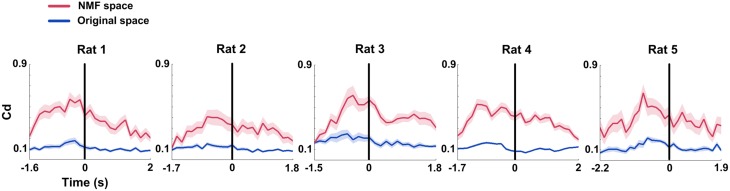
Causal density (Cd) of mPFC networks during correct WM trials in original and NMF spaces. Red lines: NMF space. Blue lines: original space (nRat 1 = 20 trials, nRat 2 = 13 trials, nRat 3 = 18 trials, nRat 4 = 27 trials, nRat 5 = 18 trials). Cd values in the two spaces display a similar changing tendency across correct trials. They increased to peaks before the RT (time 0, black vertical line). Cd in NMF space was significantly higher than that in original space. Abscissa: time course that the rat ran from the start point to the reward site. Shaded area indicates the SEM.